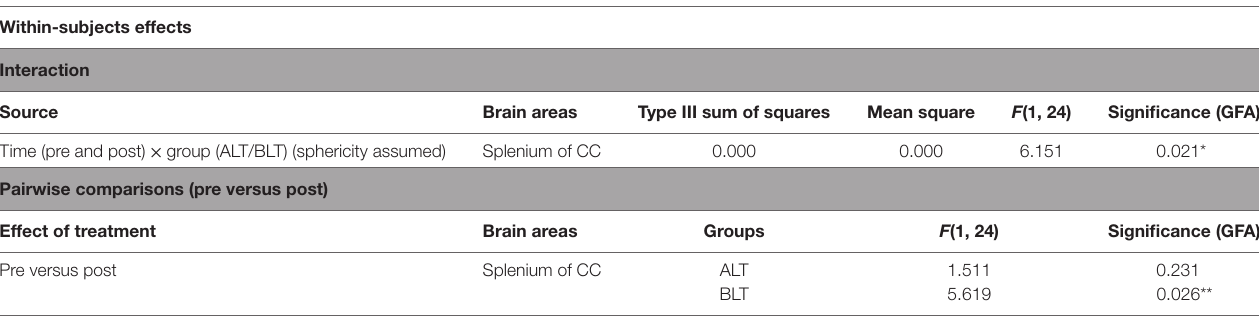
TaBle 1 | Summary of analysis of variance (repeated measures ANOVA) for GFA.